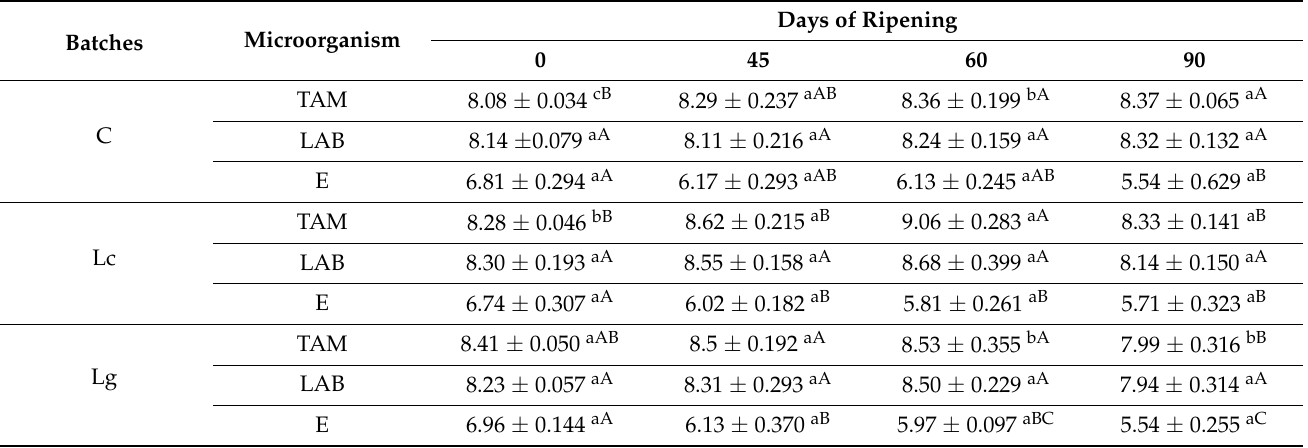
Table 1. Counts of total aerobic microorganism (TAM), lactic-acid bacteria (LAB) and Enterobacteriaceae (E) throughout “Torta del Casar” cheese ripening. Days of Batches Microorganism